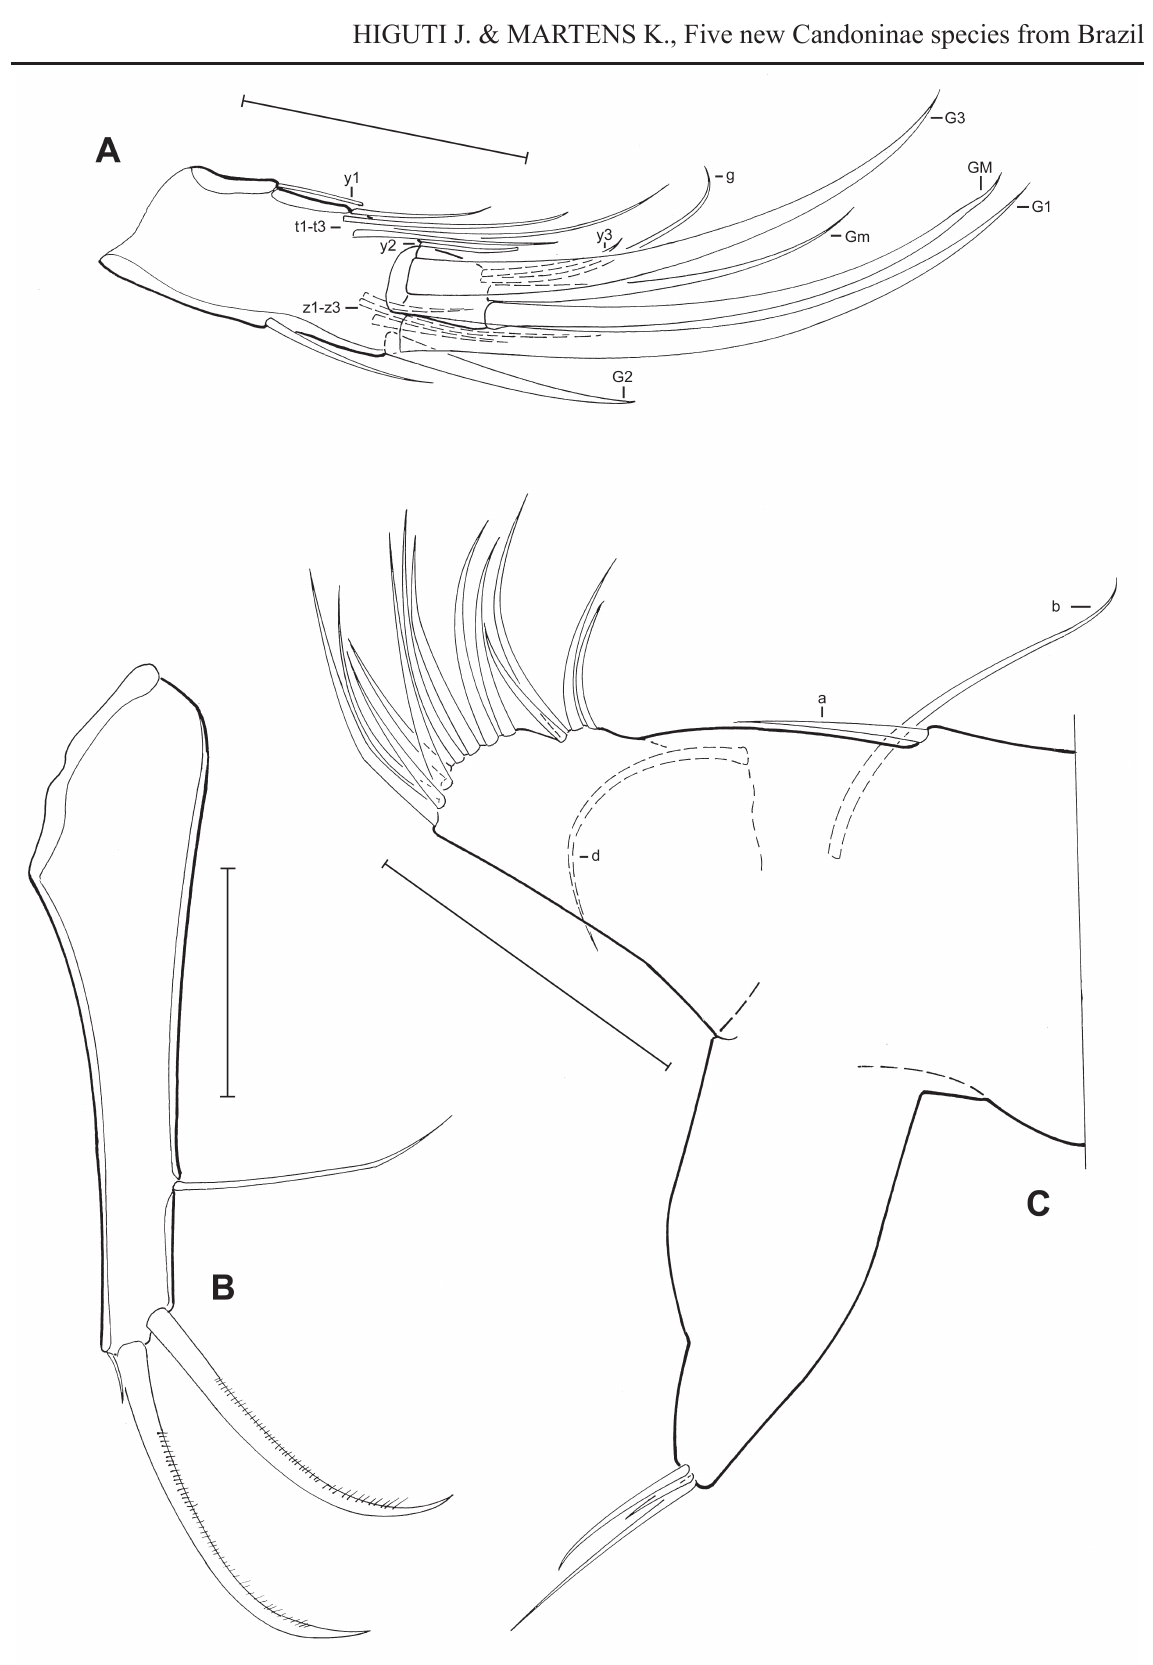
Fig. 5. Limbs of Pseudocandona agostinhoi sp. nov. (♀). A . A2, detail of the last segments (MZUSP 32654). B . Caudal ramus (MZUSP 32654). C . T1 (MZUSP 32654). Scale bars: A–C = 50